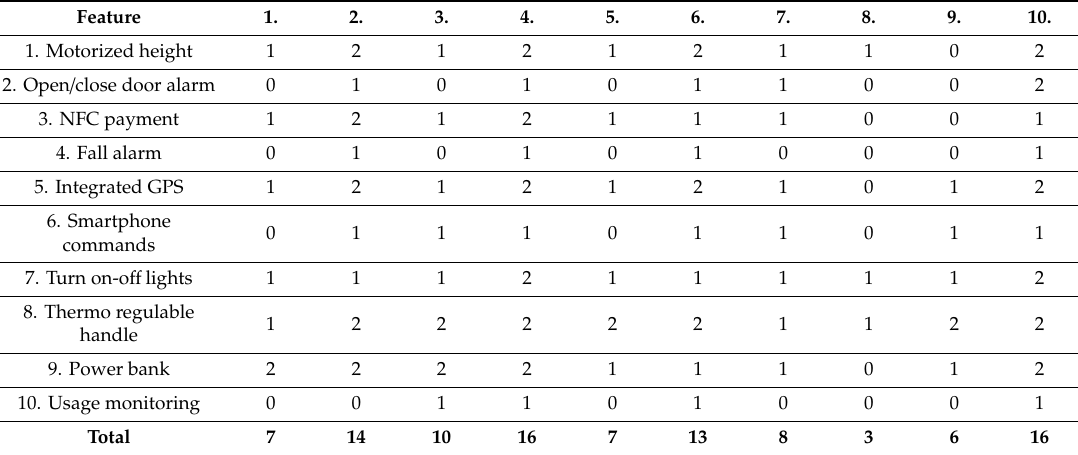
Table 3. Relationship Matrix of Relative